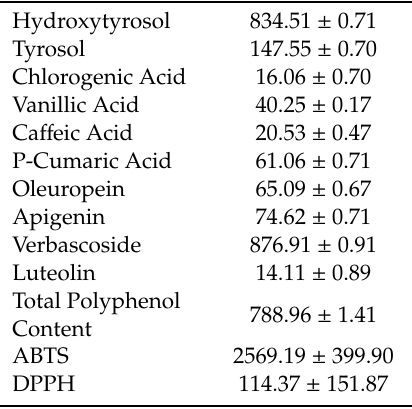
Table 1. Phenolic characterisation and antioxidant activity of wastewaters extract (WE). Data